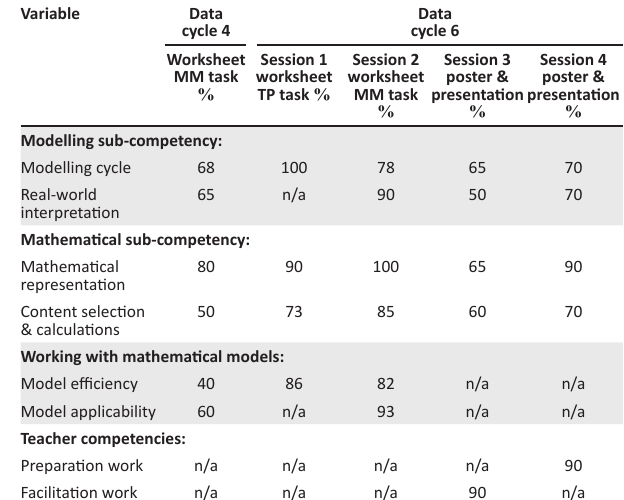
TABLE 2 : Overall mean scores as percentages related to developing competencies (Theme 1) collected in cycles 4 and 6 via worksheets and poster presentations.